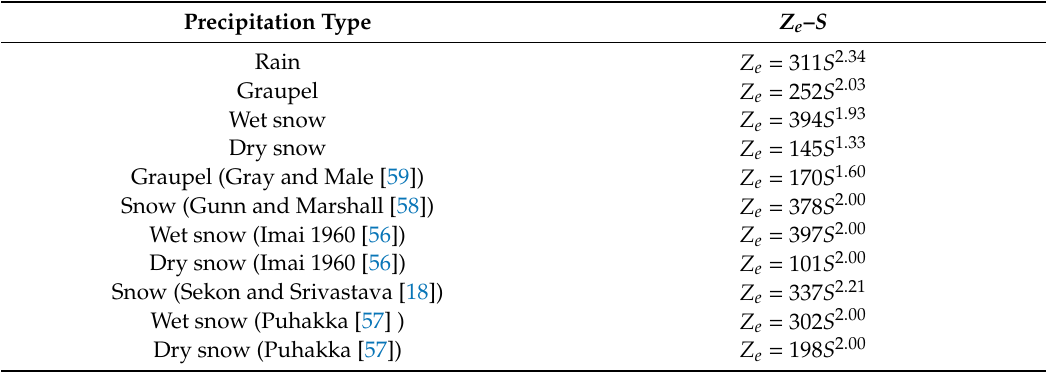
Figure 6. The scatter distributions of Z e – S (gray triangle, asterisk, cross, square) and Z e – S fitted functions (yellow, cyan, red and blue solid lines) of rain, graupel, wet snow and dry snow, respectively. In addition, the Z e – S relationships (dotted or dashed lines) from previous studies are shown in this figure. The details are shown in Table 6. Table 6. The Z e – S relationship of different types of precipitation and previous studies. The previously studied Z e – S relationship is converted from Z e = 0.189 Z .